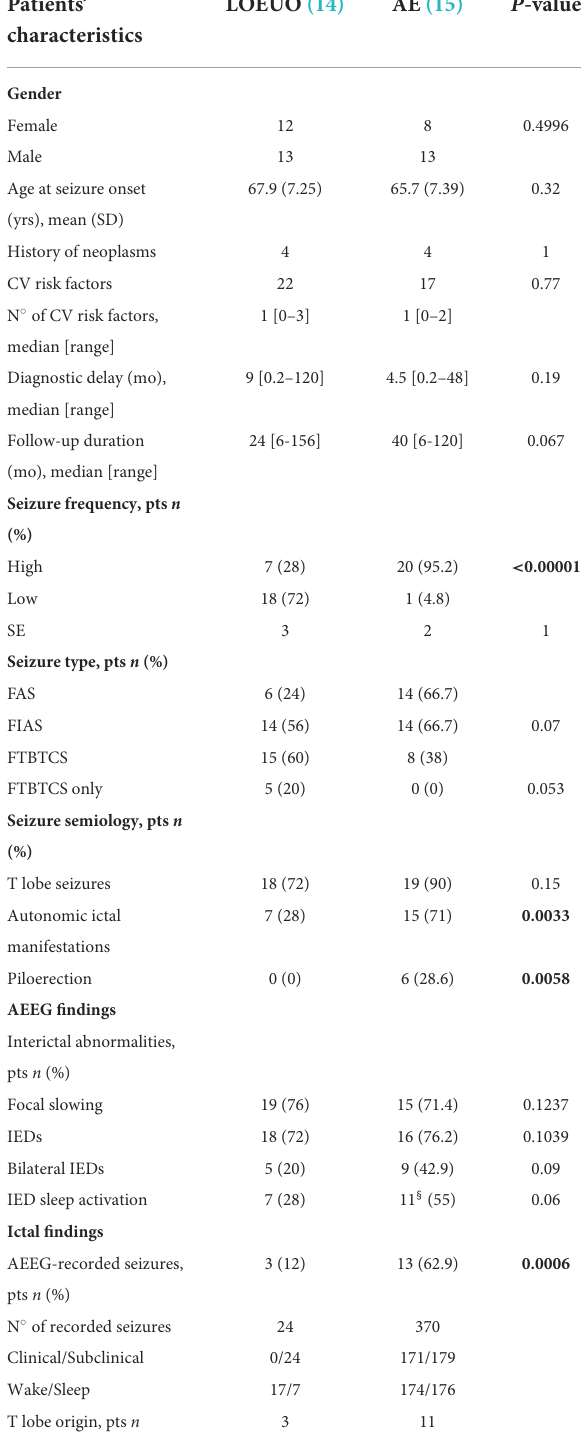
TABLE 1 General characteristics and electroclinical features of LOEUO compared with AE. Patients’